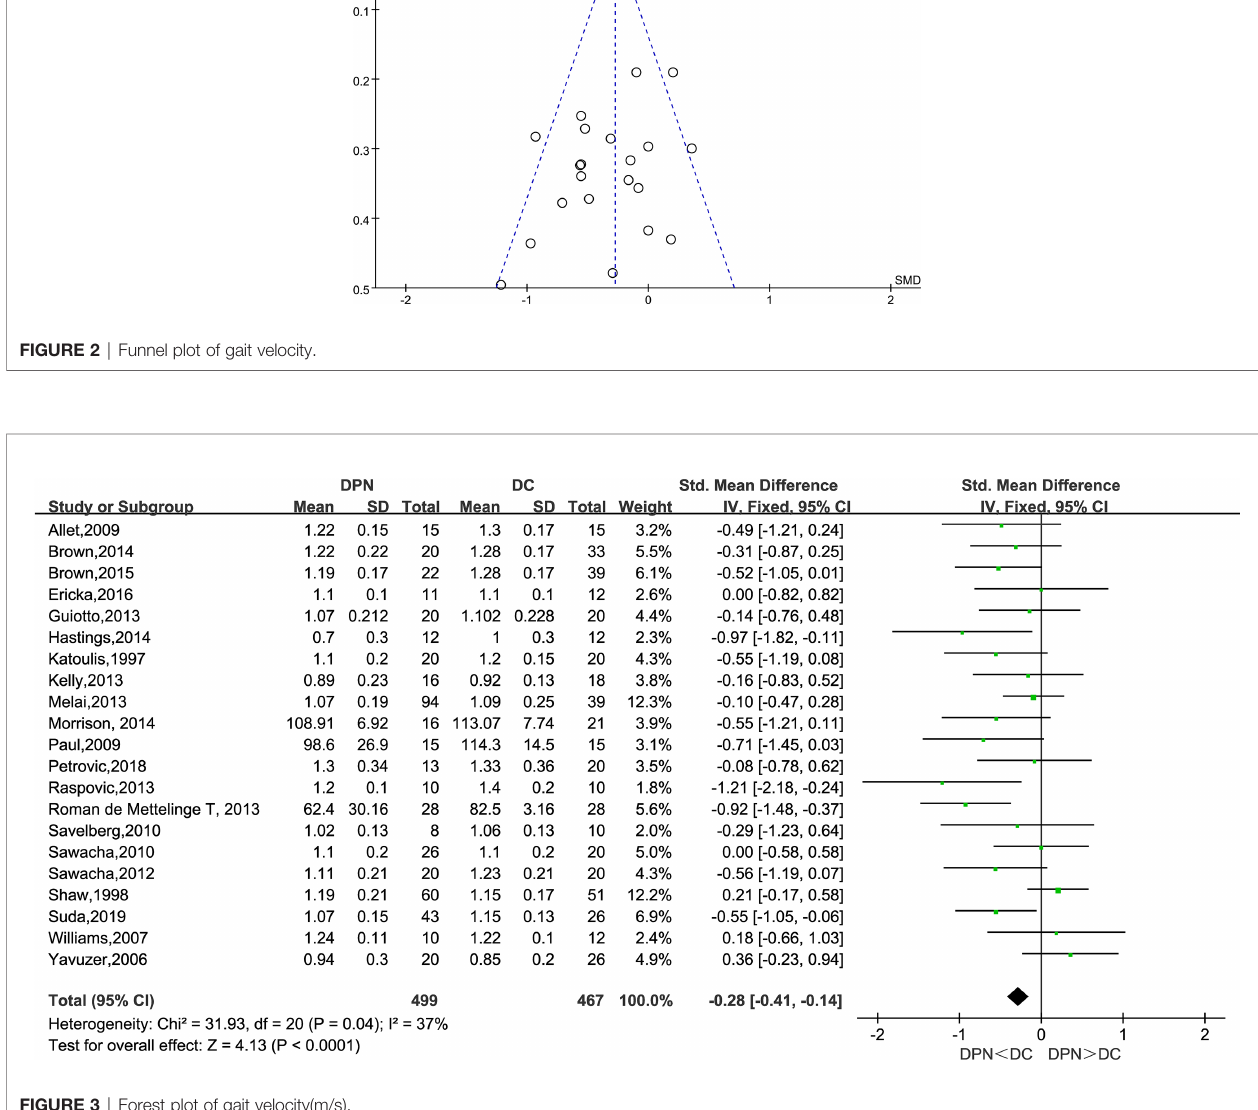
FIGURE 3 | Forest plot of gait